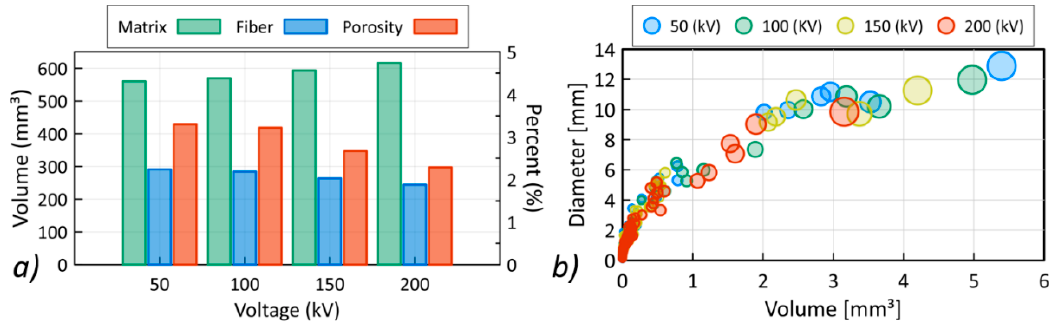
Figure 9. Volume change for the matrix, fibers, and porosity ( a ), change in volume and size of pores, ( b ) with increasing voltages of the X-ray tube.